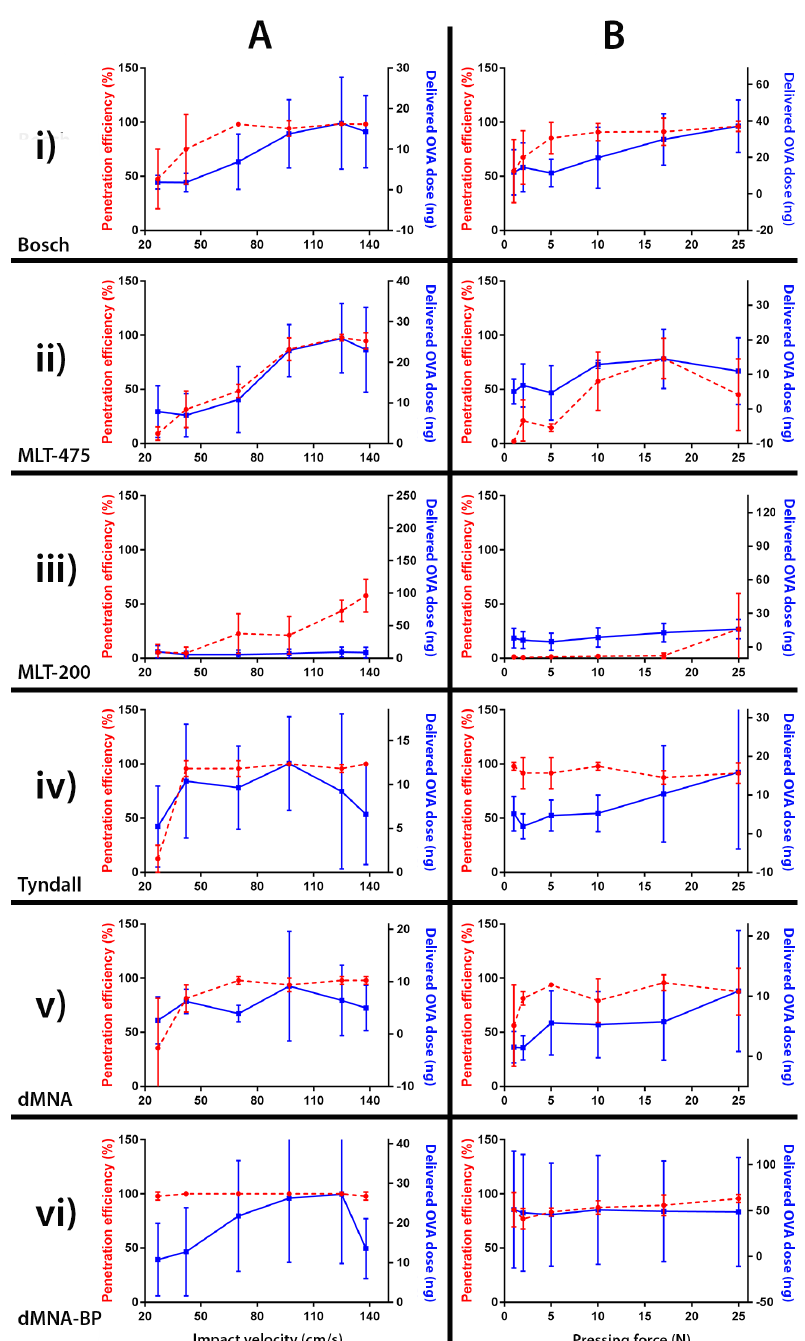
Figure 11. Penetration efficiency (in percentage) (red dotted line) and delivered dose of ovalbumin-IRDye 800CW (maximum dose delivery value matching the corresponding penetration efficiency value) (blue continuous line) into in vitro human skin as a function of the microneedle impact velocity ( A ) or pressing force ( B ). Six different microneedle arrays (MNAs) were used, having different geometries and lengths: Bosch of 320 µ m ( i ), MLT-475 of 475 µ m ( ii ), MLT-200 of 200 µ m ( iii ), and Tyndall ( iv ) dMNA ( v ) and dMNA-BP ( vi ) of 300 µ m. Data are shown as mean ± SD ( n = 3). OVA: